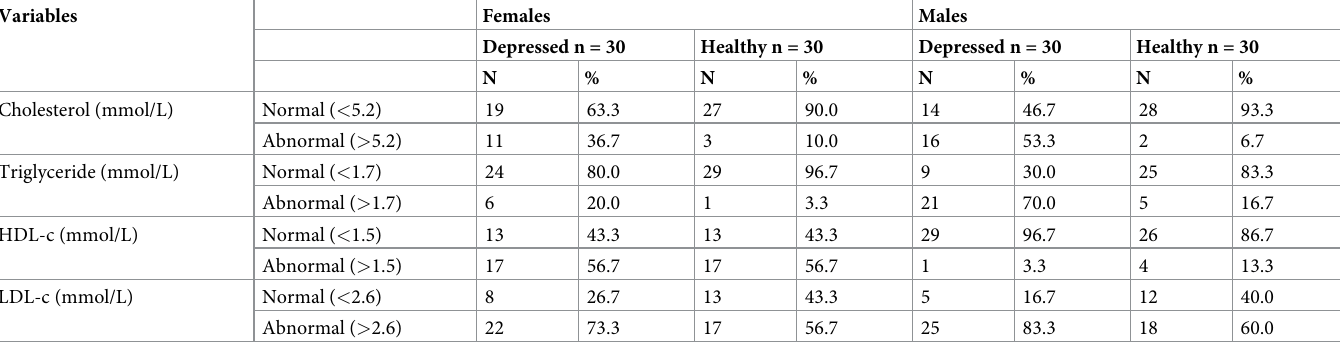
Table 4. Cholesterol, triglycerides, high-density lipoproteins cholesterol (HDL-c), and low-density lipoproteins cholesterol (LDL-c) levels of